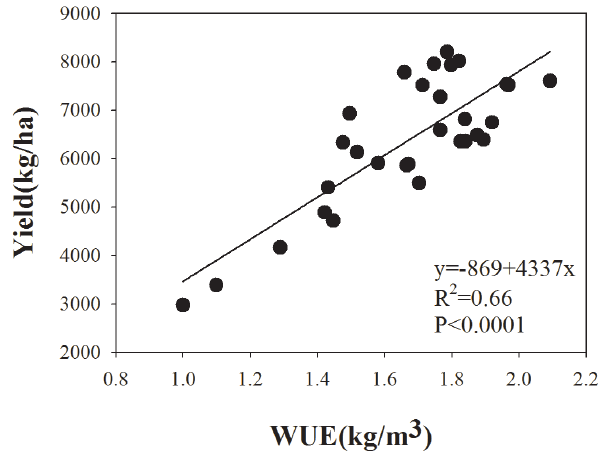
Figure 5. Relationship between WUE and grain yield (Y) for winter wheat in northwest China. The relation between WUE and yield could be deduced from the liner equation.